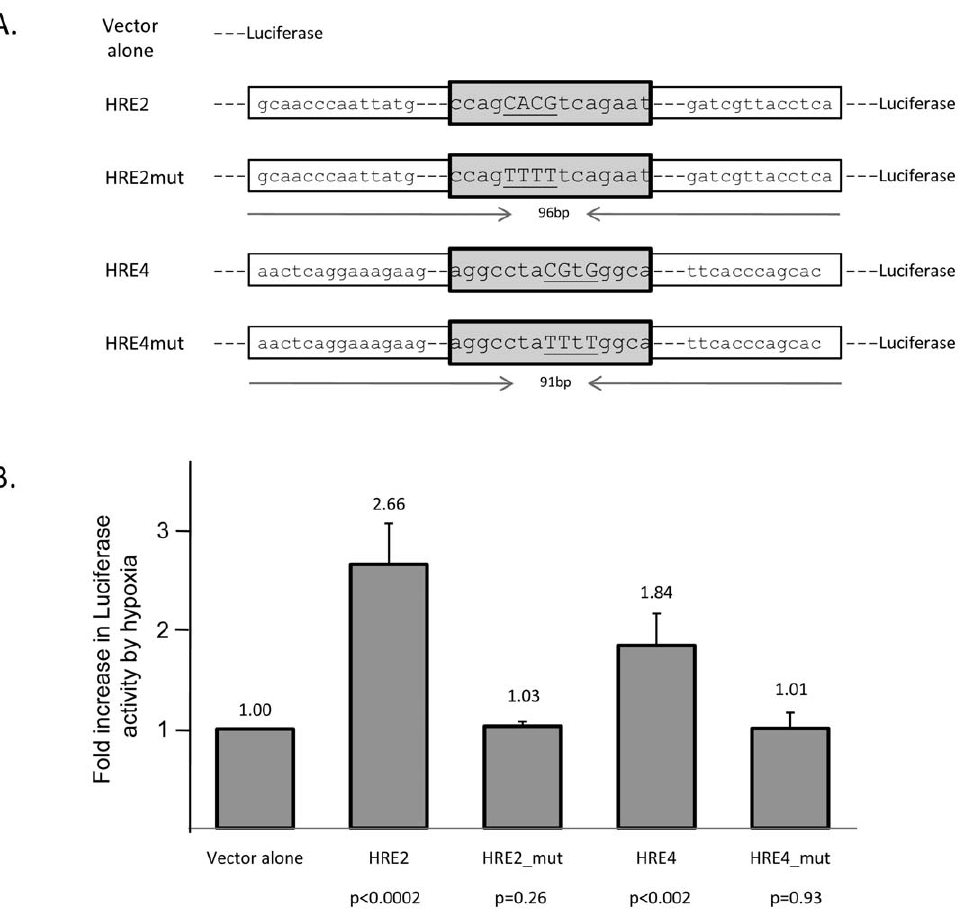
Figure 6. HRE-2 and HRE-4 can confer hypoxia inducible expression to a luciferase gene. (A) Sequence of wildtype and mutated versions of HRE-2 and HRE-4. (B) Luciferase activity in HEK293T cells transfected with the indicated plasmids at 20% or 1% O 2 . The firefly luciferase activity is normalized with renilla luciferase expression. Fold increase in luciferase activity was normalized with the increase observed in the control plasmid set to 1.0. p value was calculated to compare the luciferase activity under 20% versus 1% O 2 . Each bar represents the average of three to twelve individual transfections.